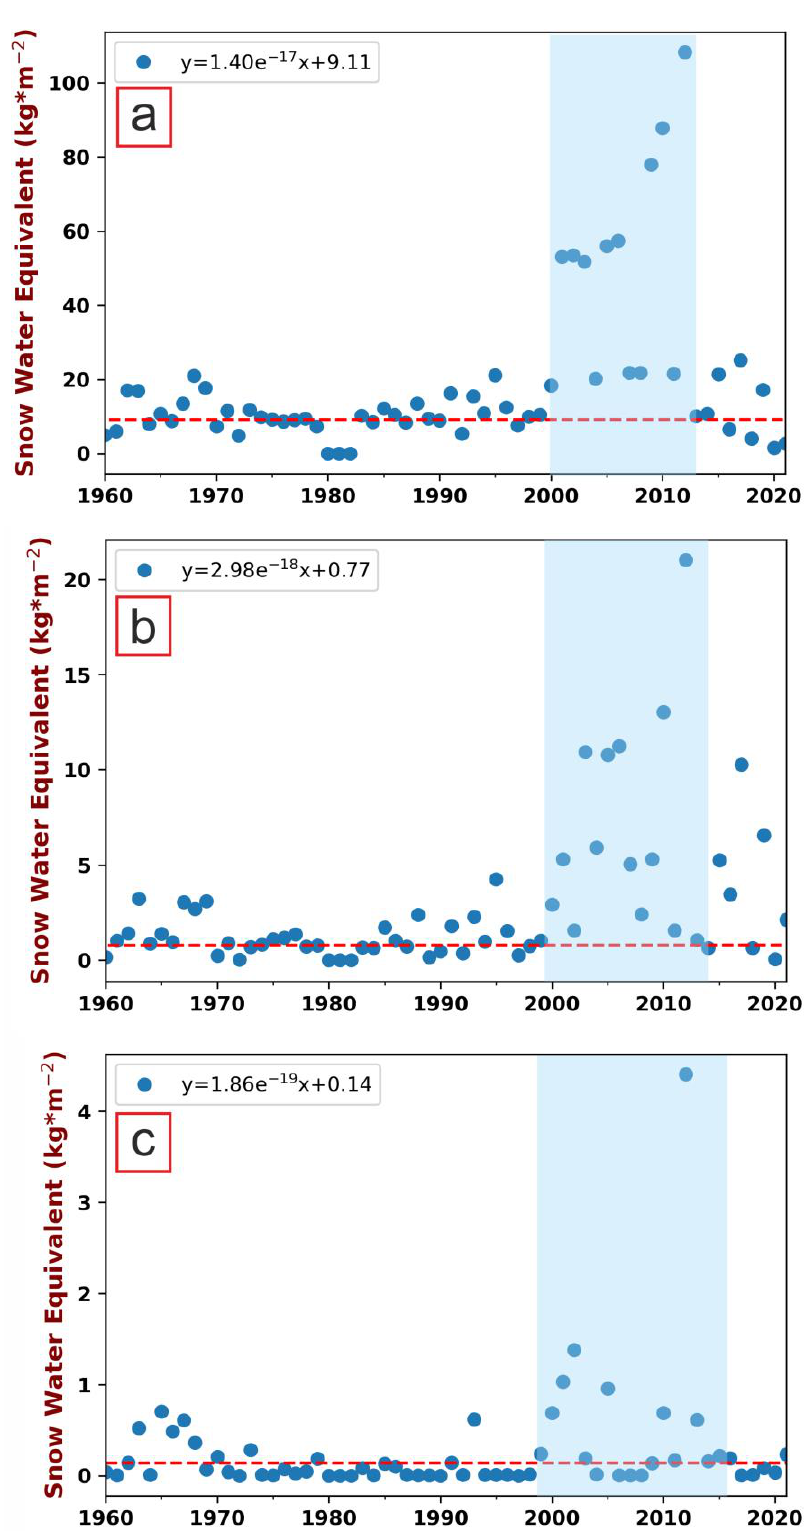
Figure 5. Monthly averaged accumulative snow water equivalent (kg/m 2 ) time series: ( a ) in Anthemountas basin, ( b ) in Mouriki basin, and ( c ) in Upper Volturno-Calore basin, during the period 1960 – 2021 derived from the GLDAS dataset. Highlighted is the period with the increased values.